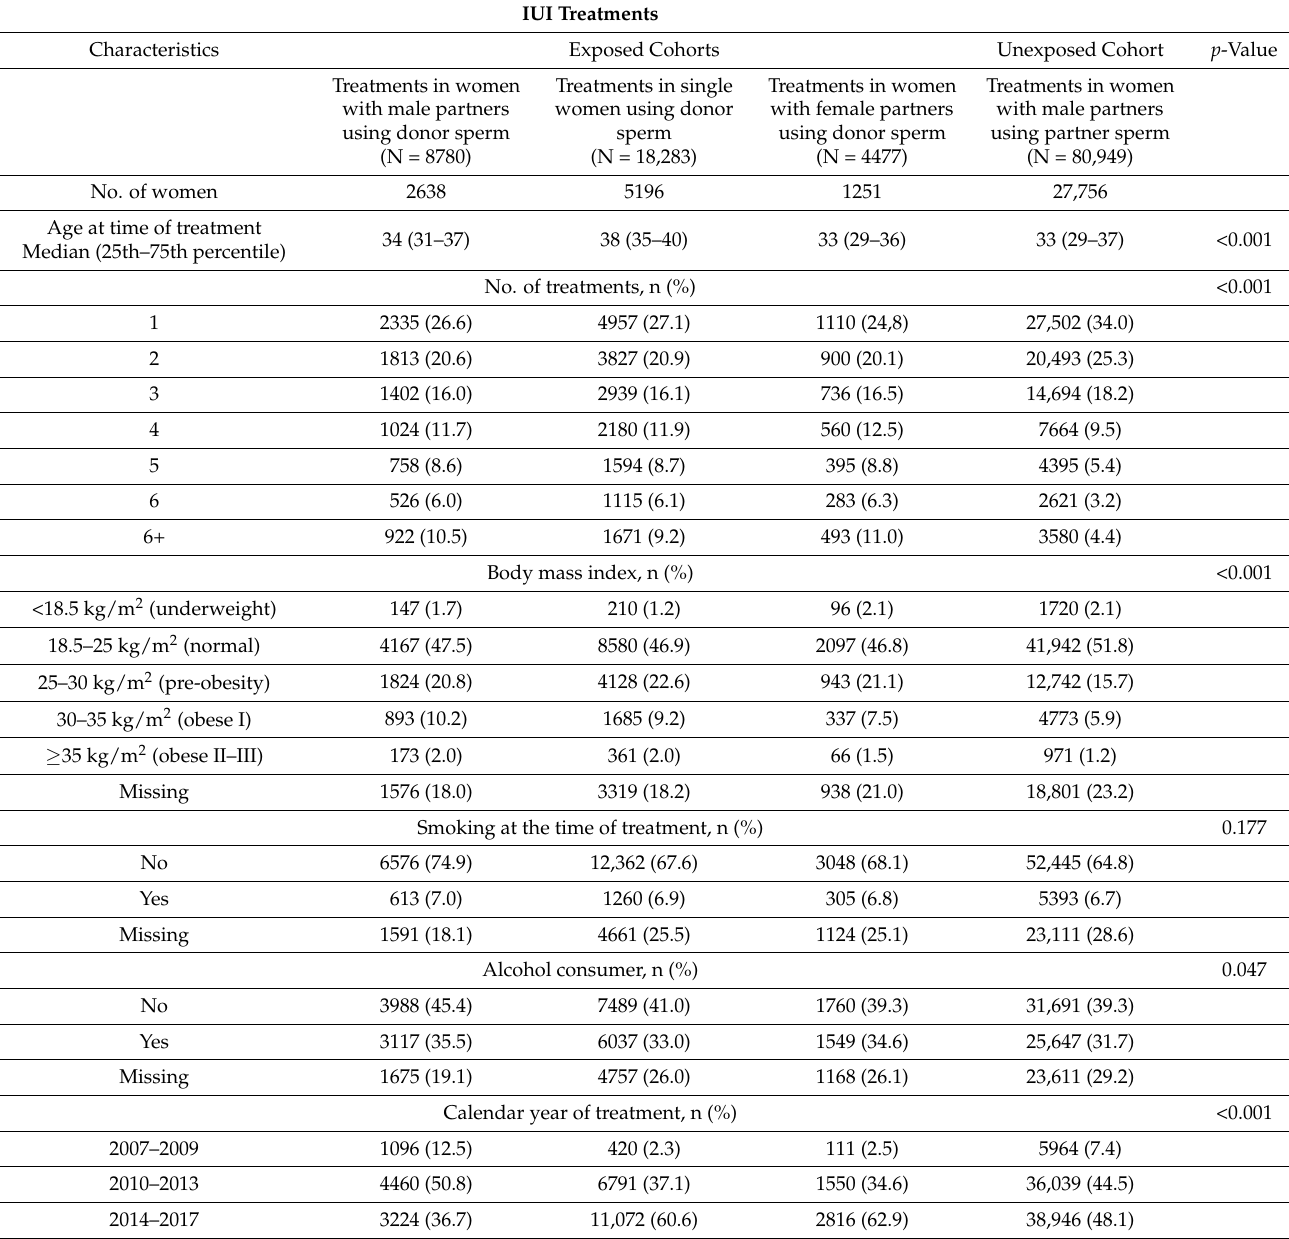
Table 1. Descriptive characteristics of the study cohorts for IUI and IVF treatments of women with male partners using donor sperm, single women using donor sperm, women with female partners using donor sperm, and women with male partners using partner sperm from 2007 to